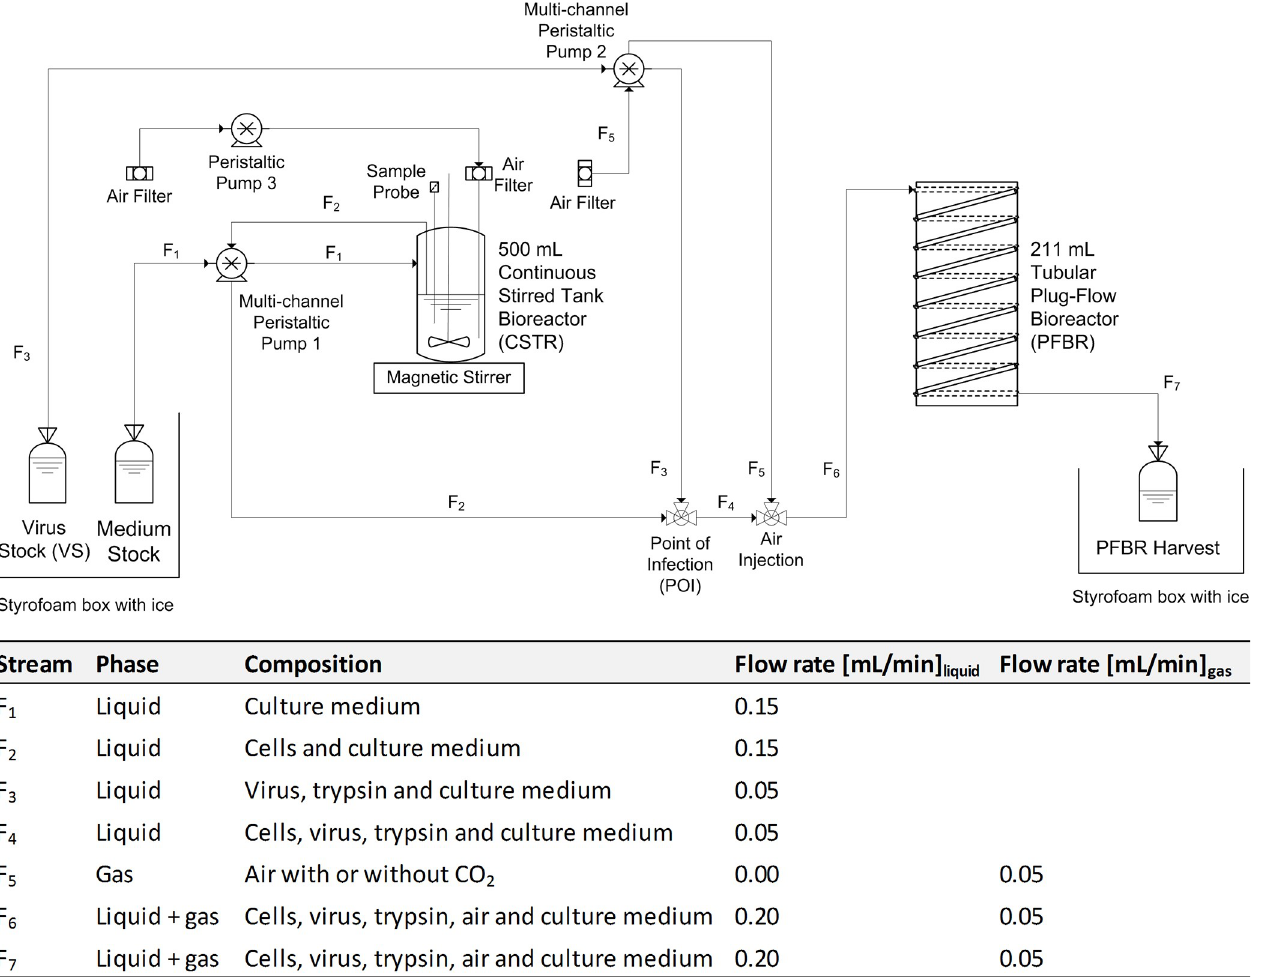
Fig 1. Process flow diagram of the continuous tubular bioreactor system for influenza virus production. The system was built with a CSTR and a coiled tubular plug-flow bioreactor (PFBR) in series. The complete bioreactor system was installed inside a cultivation room at 37˚C. The CSTR was operated as a chemostat with a dilution rate of approx. 0.9 ×μ max . The PFBR was constructed using a transparent silicone tube that was coiled around a PLEXIGLAS 1 XT tube of 20 cm internal diameter and 1 m